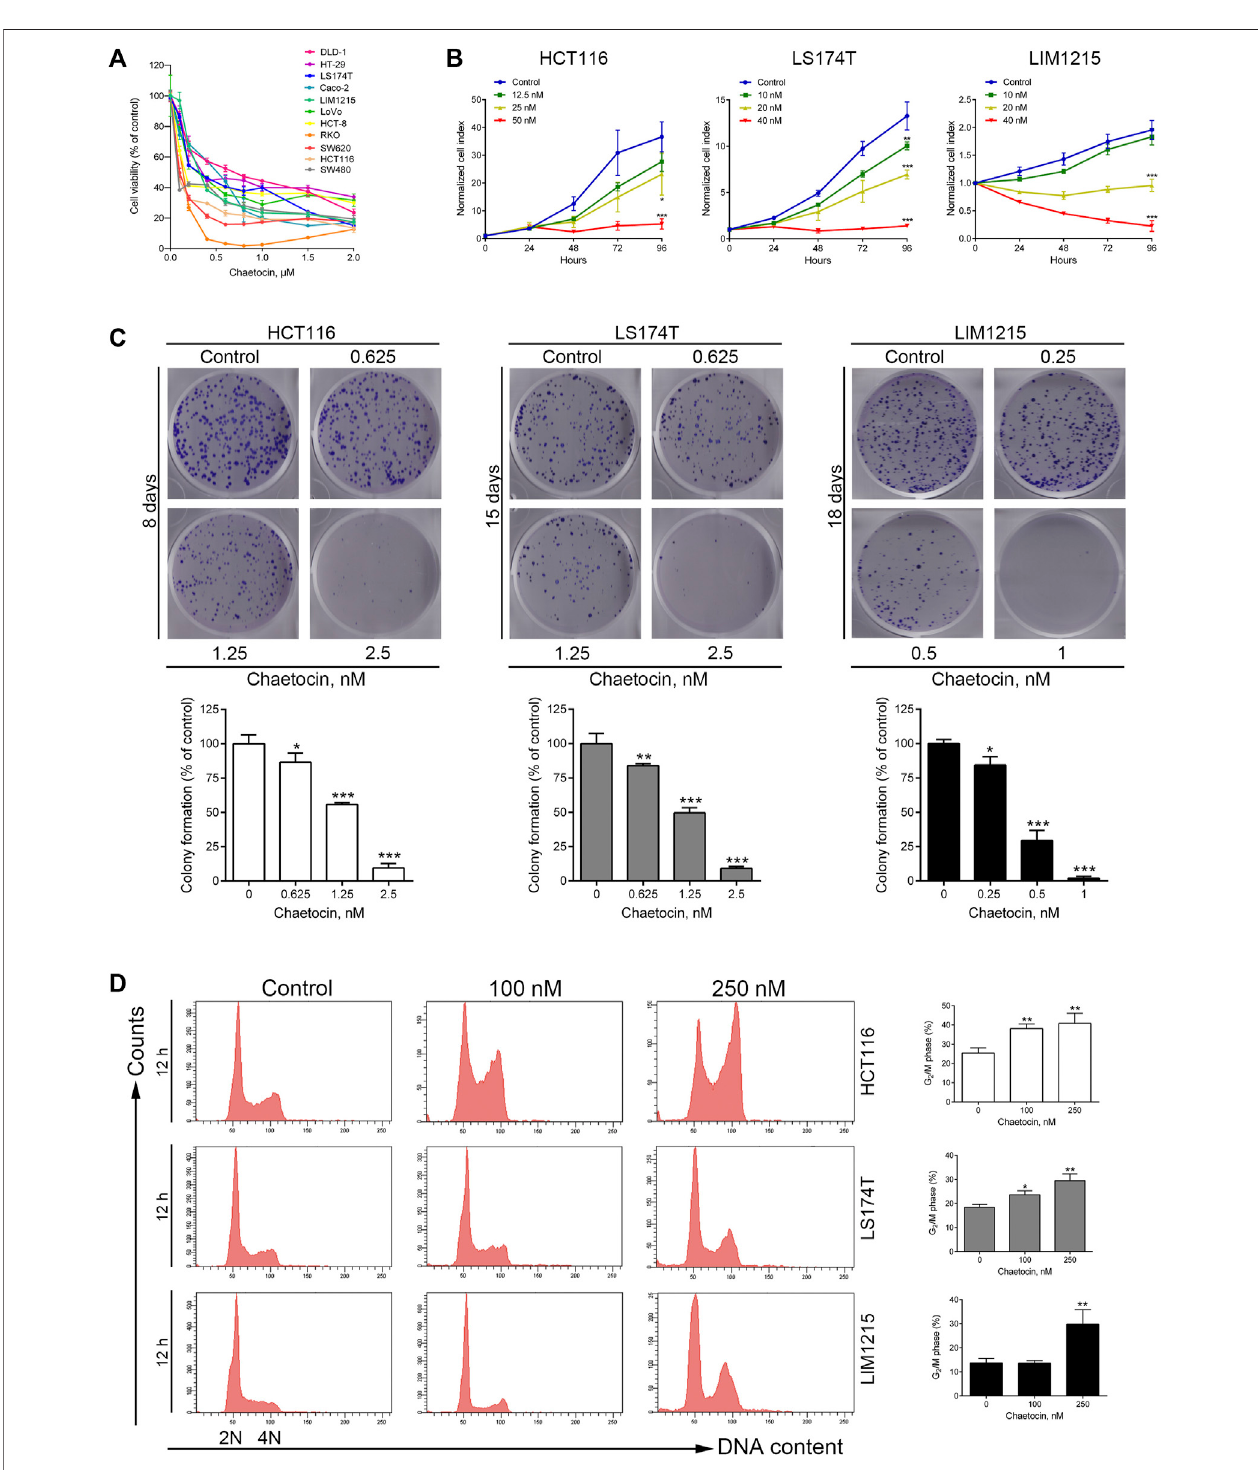
FIGURE1| ChaetocinInhibitscellproliferationandcausesG2/Mphasearrest. (A) Followedbytreatedwithchaetocinatincreasingconcentrationsfor24 h,CCK8 assay was used to measure the viability of CRC cells. (B) Real-time cell analysis results on the proliferation of HCT116, LS174T and LIM1215 cells. (C) After treated with chaetocinforindicateddays,numberofnewcoloniesformedwerecounted. (D) CellcycledistributionanalysisonCRCcelllinesafter12 hchaetocintreatmentatvarious concentrationsdetectedbyPI-stained fl owcytometry.For (C) and (D) , resultswereshownasmean ± SD ofthree independentexperiments. * p < 0.05,** p < 0.01, *** p < 0.001, versus control group.